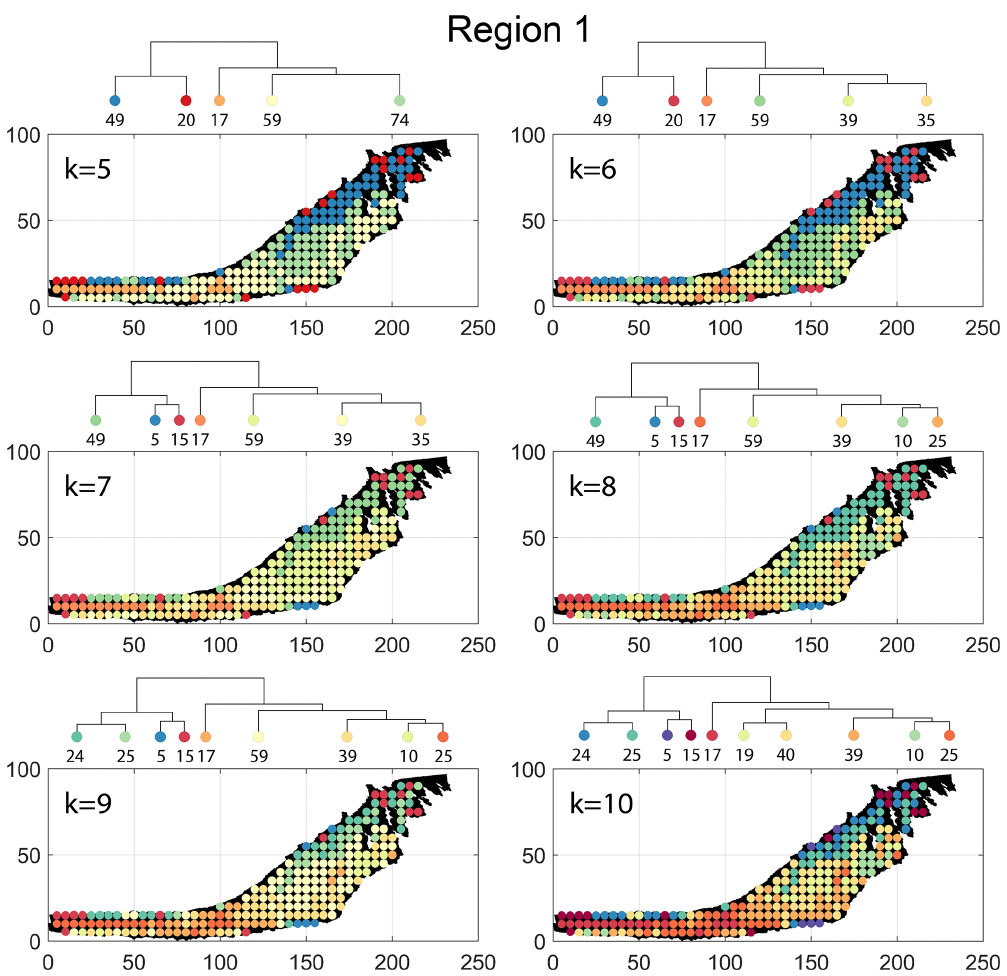
Figure B2. Variation in cluster boundaries for “ k ” clusters in Region 1 using